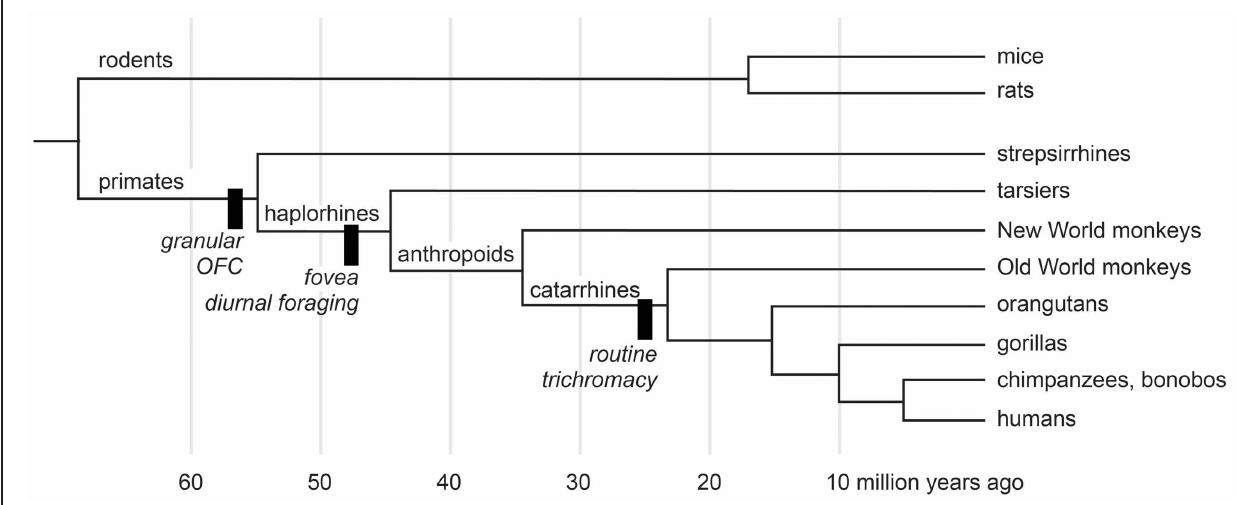
Frontiers in Neuroscience | Decision